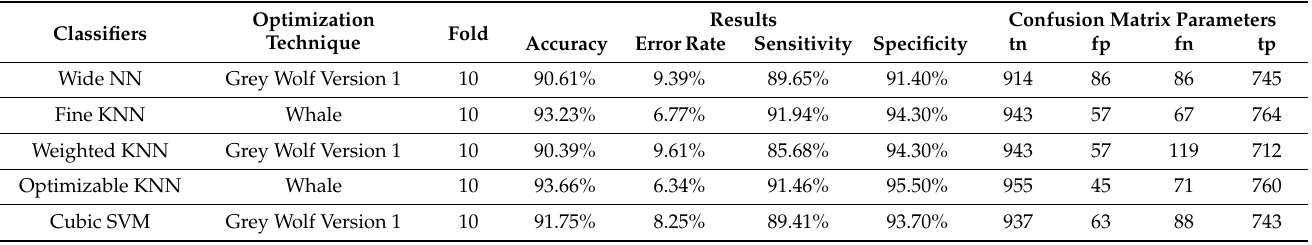
Table 7. Performance of various classifiers using GLRLM, statistical features, and GLCM